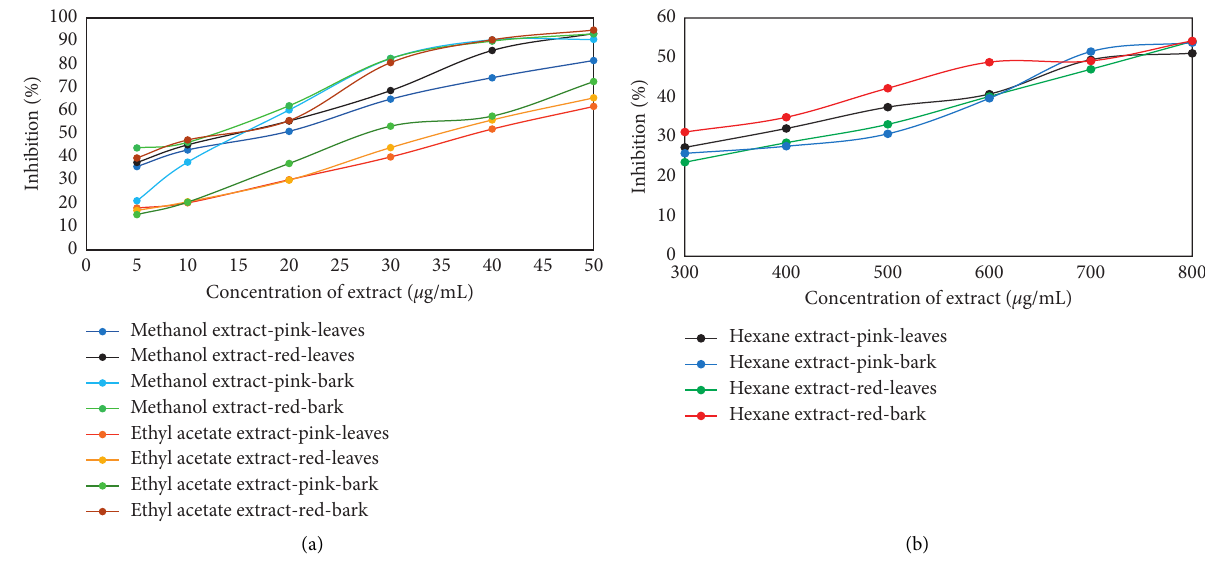
Figure 2: Antioxidant activities of various concentrations of S. aqueum leaves and stem bark extracts to DPPH radical: (a) methanol and ethyl acetate extracts and (b) hexane extracts.